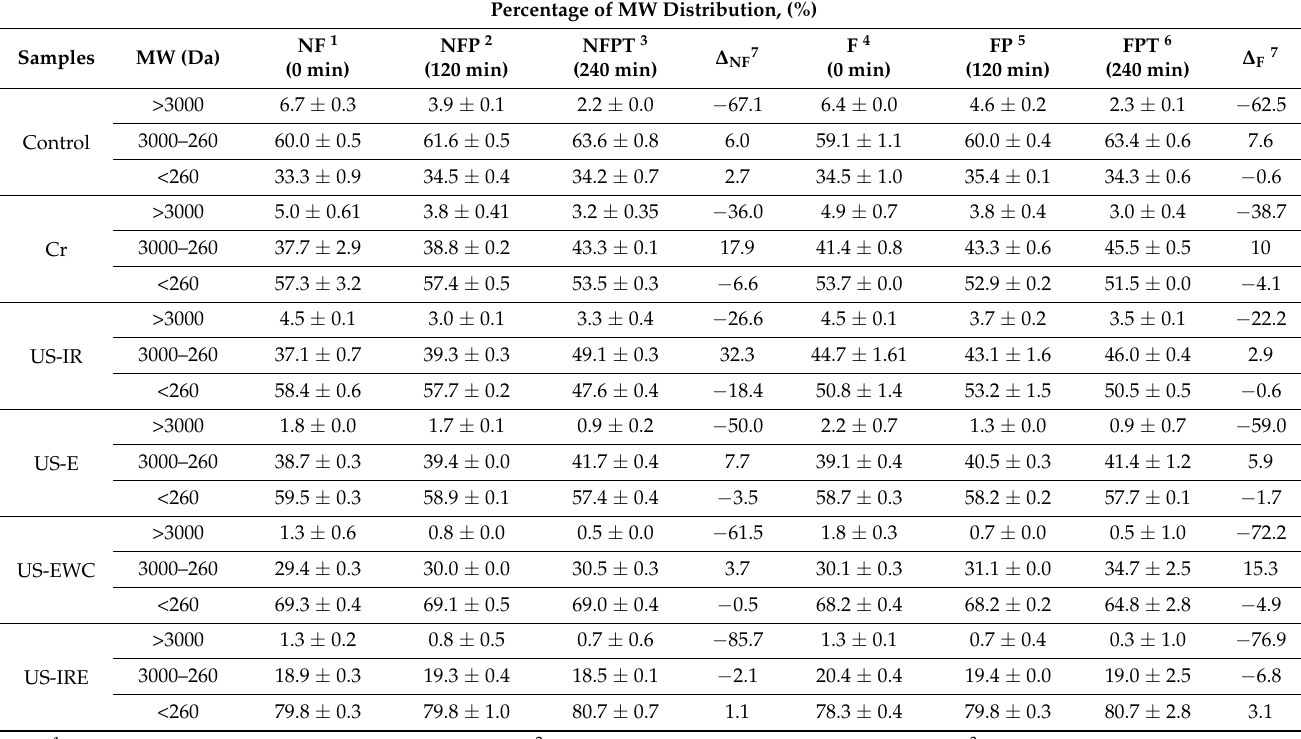
Table 2. Percentage of molecular weight (MW) distribution during digestion (0 to 240 min) of non-fermented (NF) and fermented (F) beverages non-enriched (Control), untreated cricket protein-enriched beverages (Cr) and those treated with different processes (US-IR, US-E, US-EWC and US-IRE). Data shown are means ± SD (n = 3). Percentage of MW Distribution, (%)